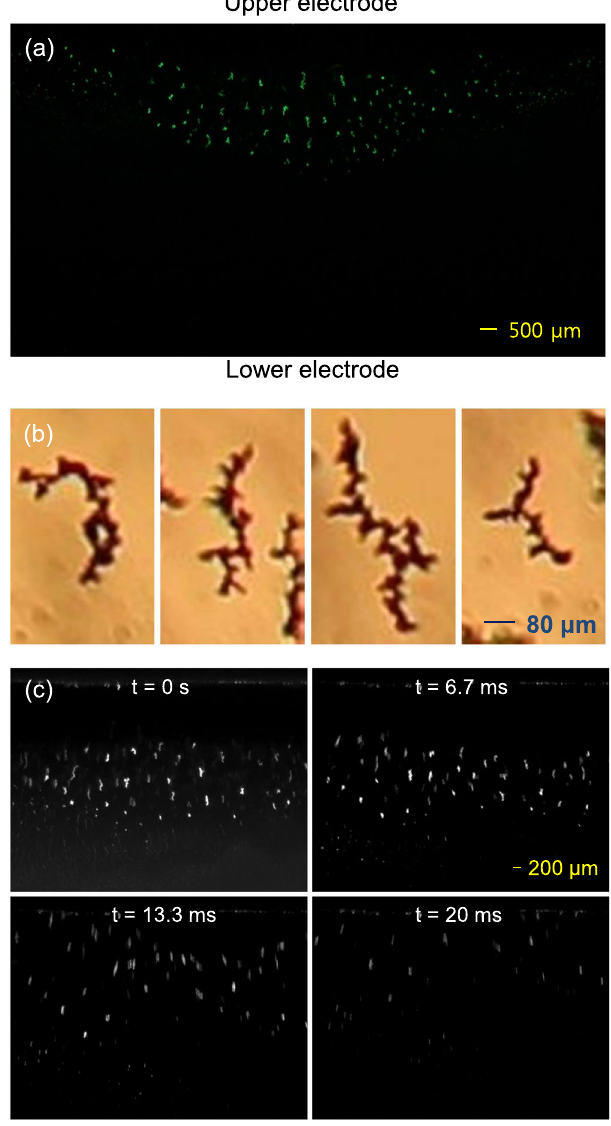
Figure 2. Alignment and force balance of nonspherical water-ice particles in a plasma. ( a ) Cloud of water-ice particles observed in the laboratory experiment and ( b ) high-resolution images of ice particles. Ice particles formed and levitating in our lab experiment are typically nonspherical (elongated) and have a fractal nature. In addition, the elongated particles typically align in a direction perpendicular to the force equilibrium line (or dust cloud edge). The observation that a dust cloud is observed only in the upper part of the plasma indicates that thermophoretic force is stronger than the gravitational force. ( c ) Motion of ice particles after the plasma is terminated. Most particles move upward after the plasma is turned off because the thermophoretic force overcomes the gravitational